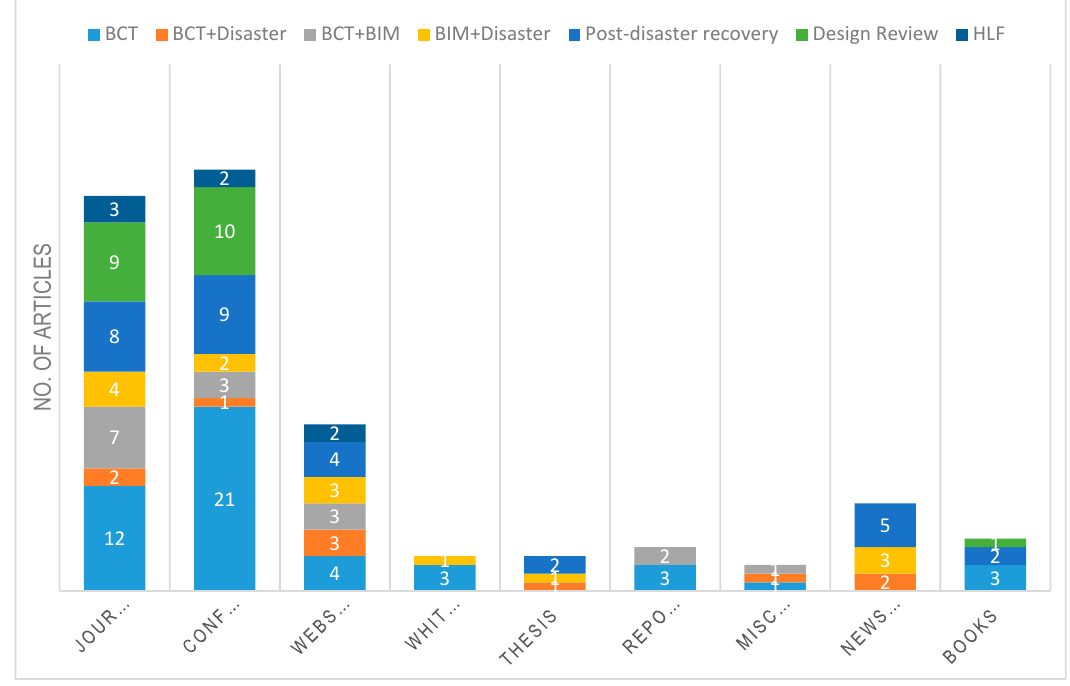
Figure 2. Summary of the review articles related to the research key aspects. BCT, Blockchain Technology; HLF, Hyperledger Fabric.